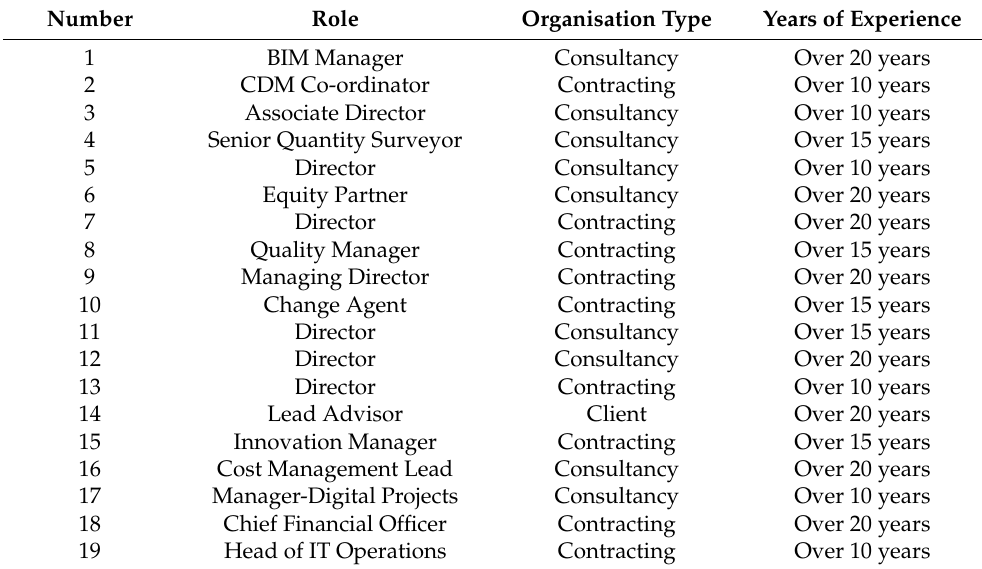
Table 1. Interviewees’ roles and experience.